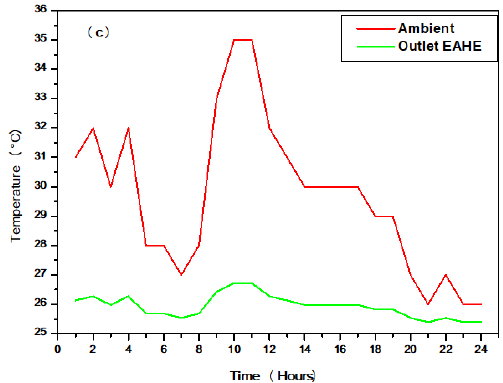
Figure 6. Hourly variation of temperature for ambient air, outlet air of EAHE for the hottest day in (a) Timimoun; (b) Djelfa; (c) Jijel.